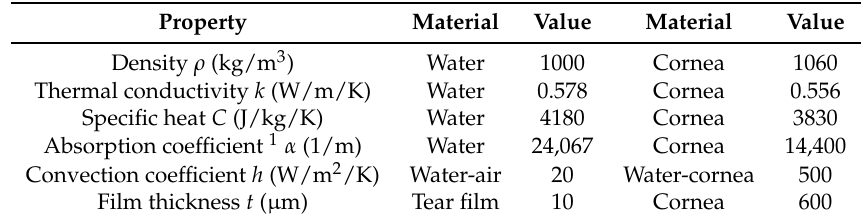
Table 1. Physical and thermal parameters of tear and aqueous humor (modelled as water), and the cornea [5,22,24] used in the